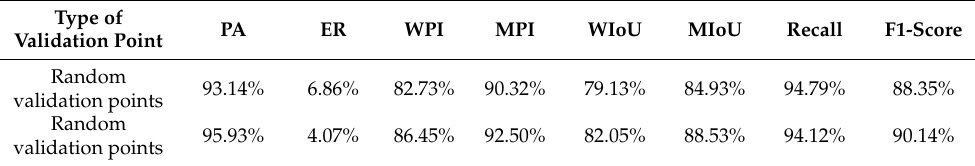
Table 10. Accuracy assessment for